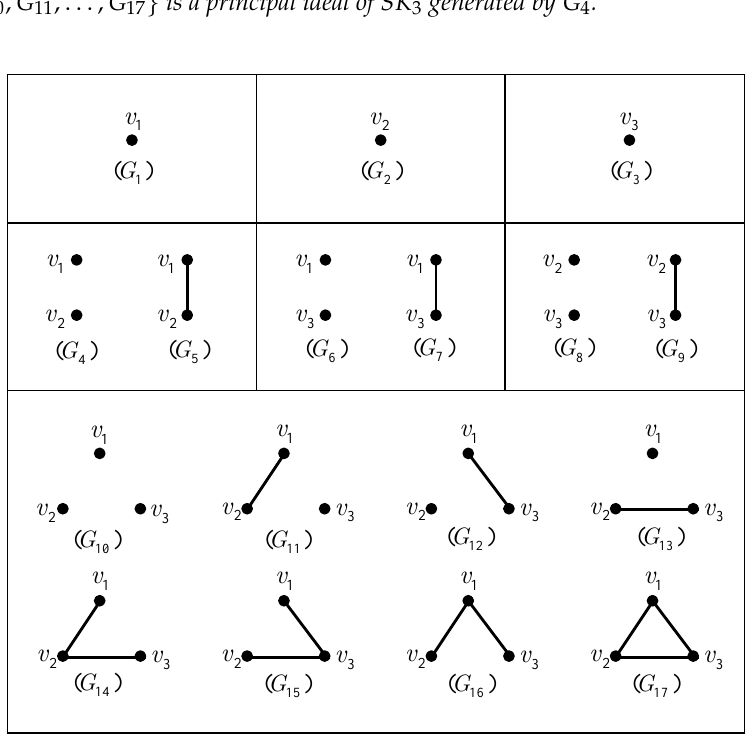
Figure 1. All elements of SK 3